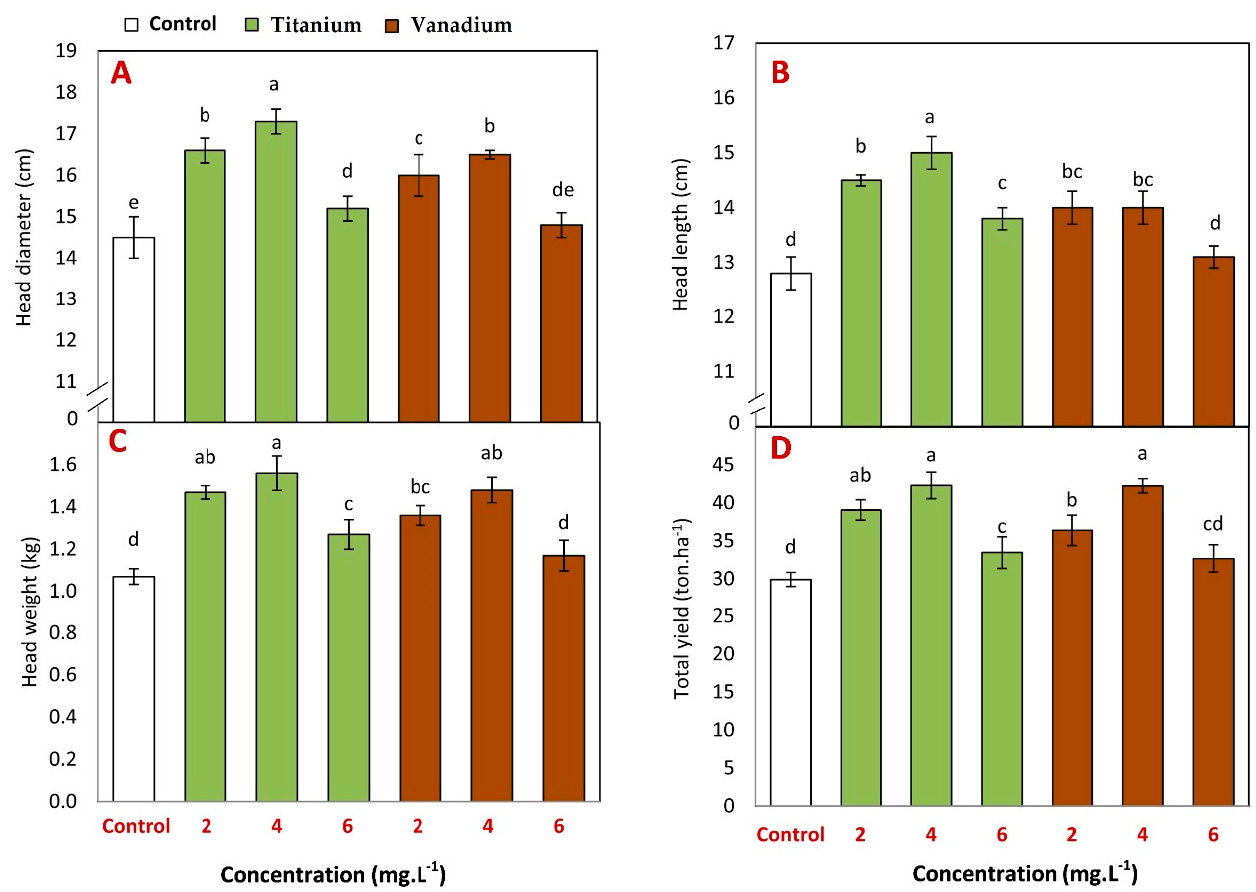
Figure 5. DPPH-scavenging activity of red cabbage leaves treated with different concentration of Ti and V. The mean values followed by a different letter are significantly different at p < 0.05 according to the Duncan test ( n = 3).